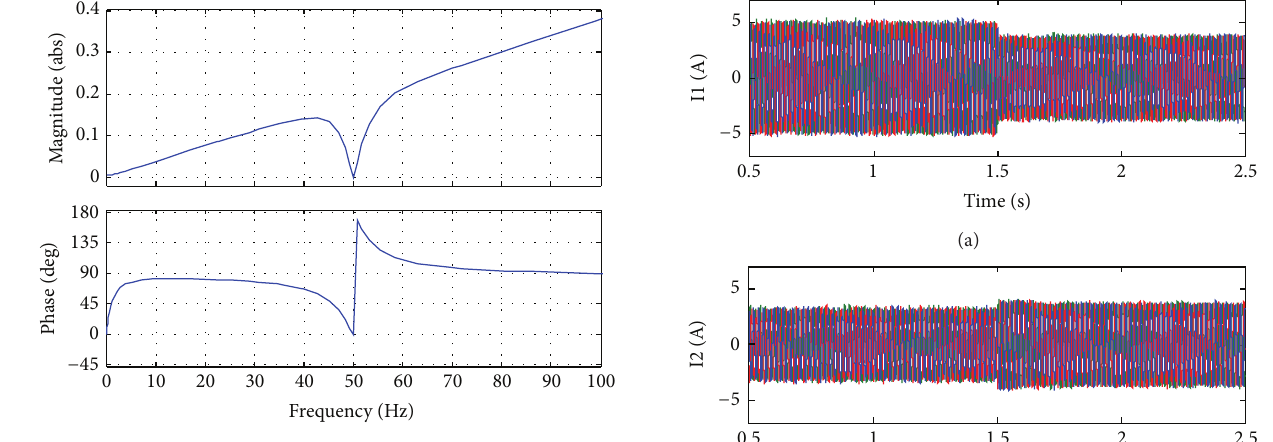
Figure 9: Bode diagram of output impedance ( 𝑍 V = 0 ).